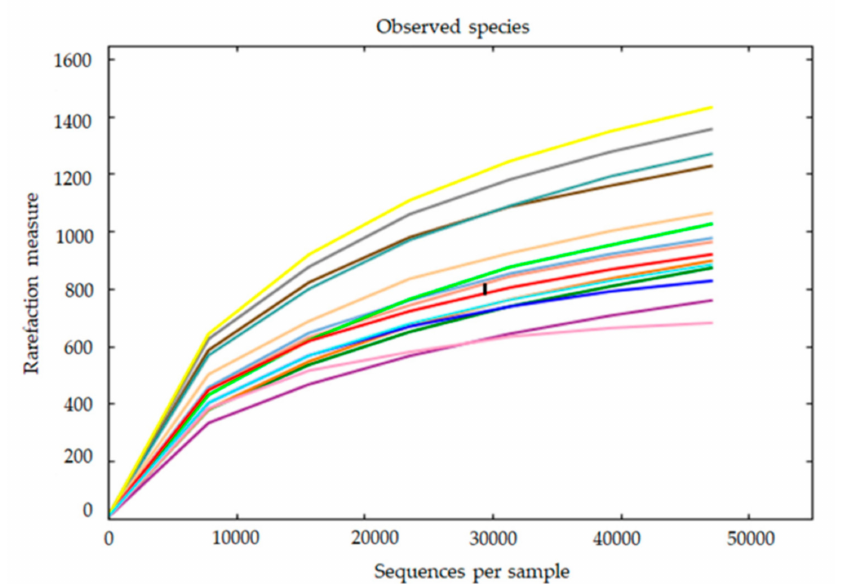
Figure 6. Rarefaction curves obtained from sequencing data of the different samples included in this study.